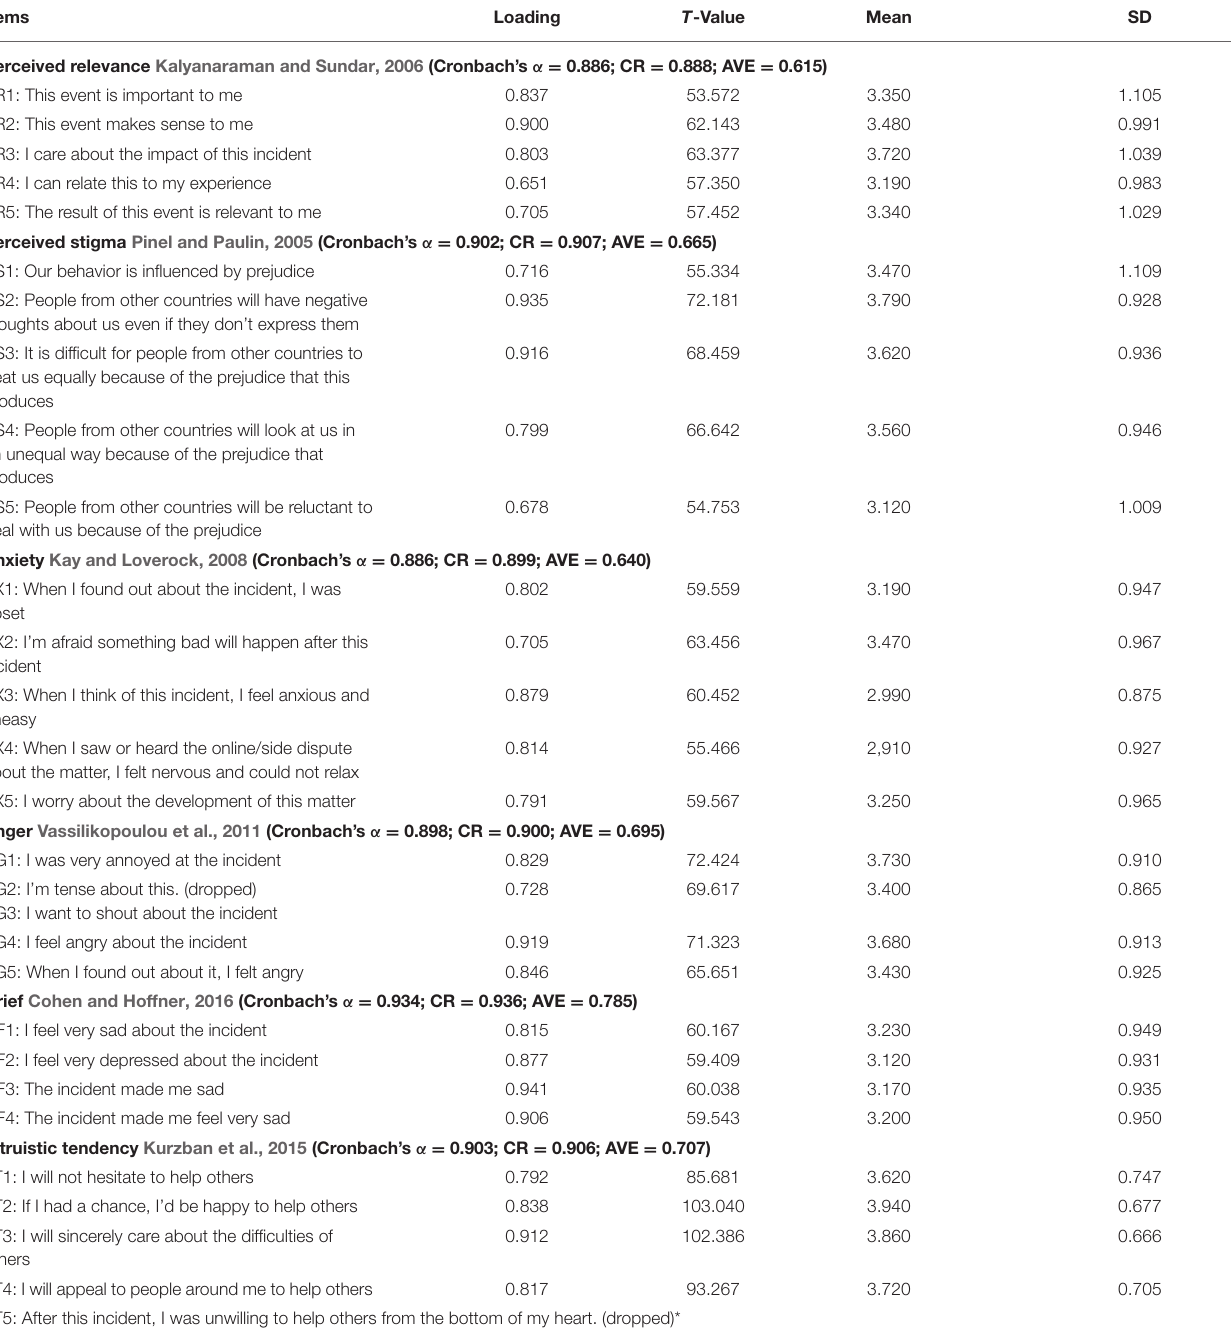
TABLE 2 | The measures and psychometric properties. Items Loading T -Value Mean